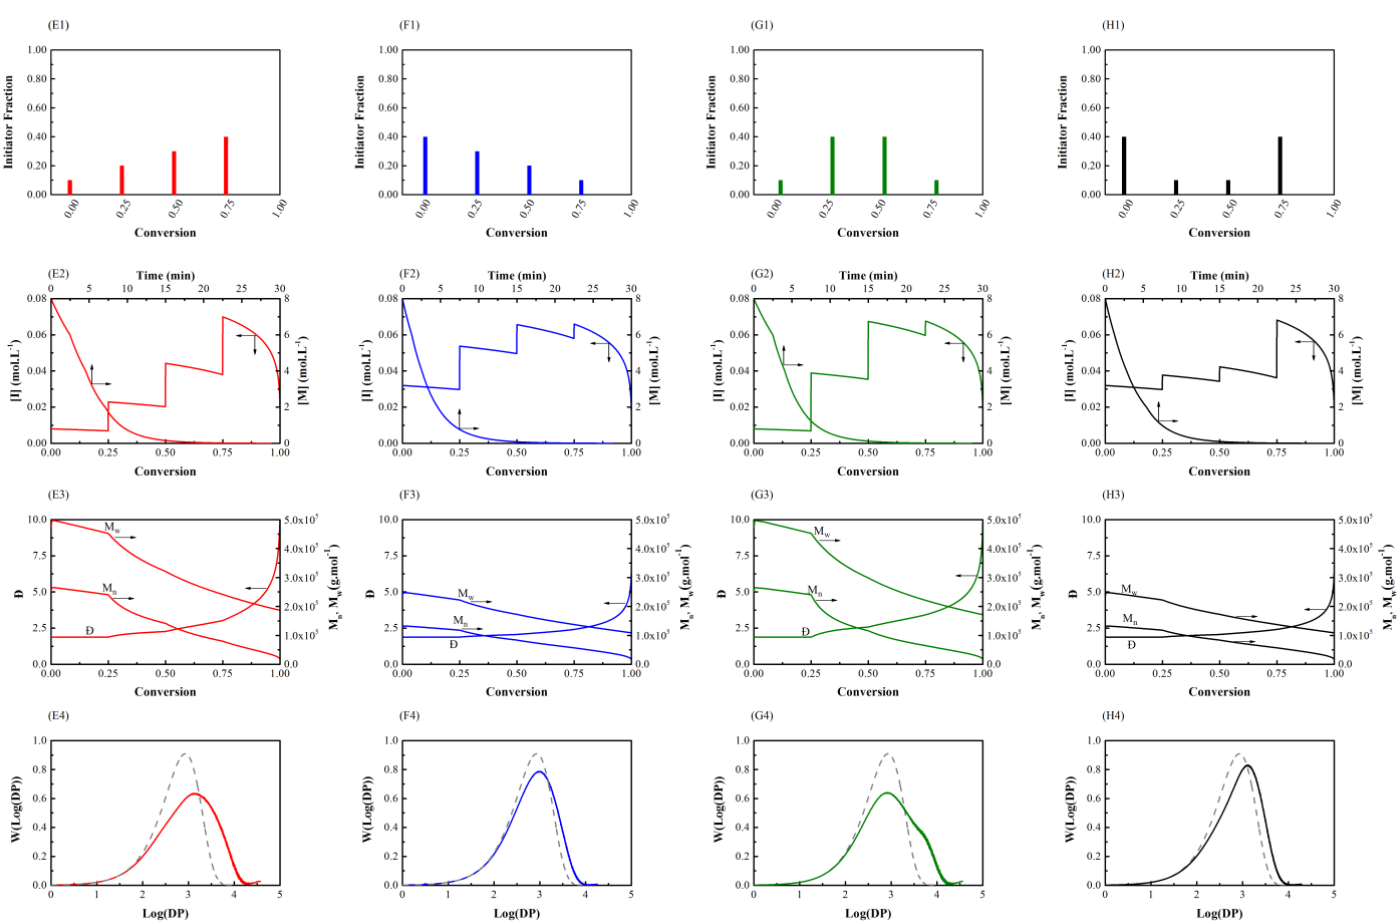
11 = 8.00 mol L –1 and Figure 2. Semi-batch general free radical polymerization (Case 1) using di ff erent amount of shots (AOS) feeding policies with initial values [ M ] 0 = 0.08 mol L –1 . First row: initiator feeding policy for AOS-1 (E [ I ] 1 ), AOS-2 (F 1 ), AOS-3 (G 1 ),and AOS-4 (H 1 ). Second row: total monomer and initiator consumption 0 versus conversion for AOS-1 (E 2 ), AOS-2 (F 2 ), AOS-3 (G 2 ), and AOS-4 (H 2 ). Third row: number- and weight-average molecular weight and dispersity versus conversion for AOS-1 (E 3 ), AOS-2 (F 3 ), AOS-3 (G 3 ), and AOS-4 (H 3 ). Fourth row: final molecular weight distribution for AOS-1 (E 4 ), AOS-2 (F 4 ), AOS-3 (G 4 ), and AOS-4 (H 4 ) (solid line), where the NOS-1 (A 4 ) result (dashed line from Figure 1) is also presented for